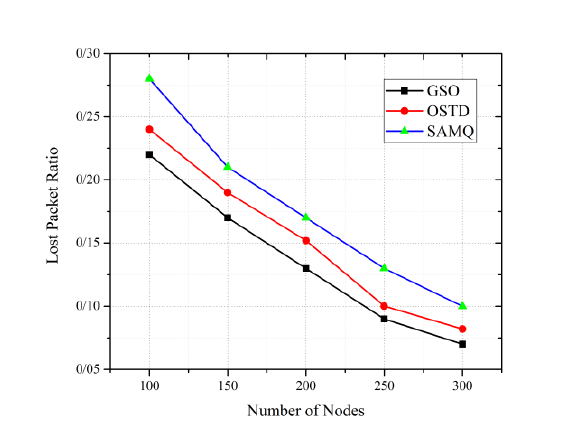
Figure 7. Lost packets